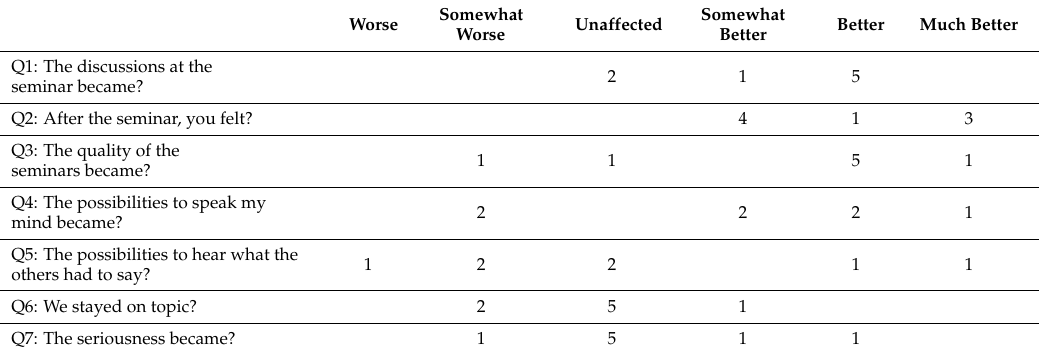
Table 3. Teachers’ perceptions of changes compared to the previous indoor seminar. Worse Somewhat